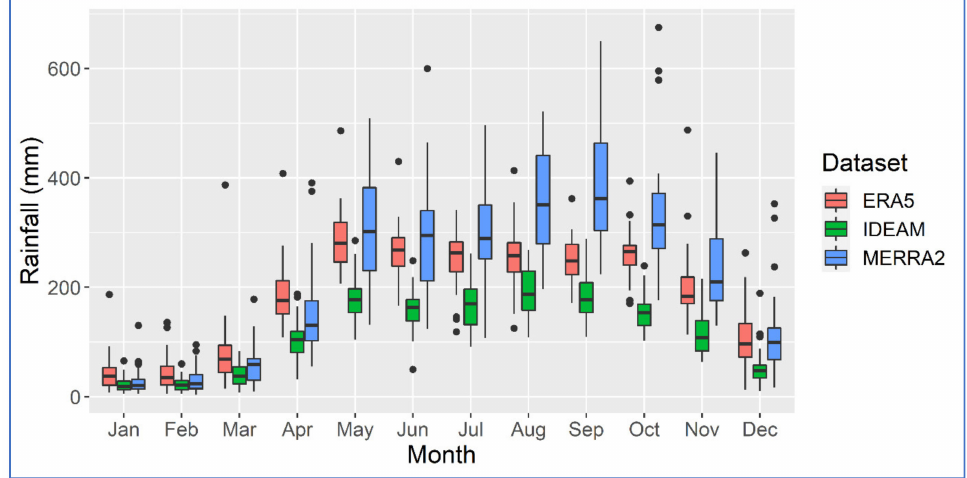
Figure 7. Average monthly rainfall in the Lower Sin ú River basin based on the three datasets for 1985–2019. In this boxplot, the extremes of the box are the first (Q1) and third (Q3) quartiles; the bar indicates the median; the whiskers correspond to Q1—1.5 IQR and Q3 + 1.5 IQR. The points are potential